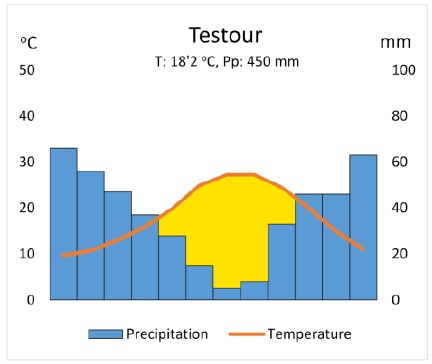
Figure 5. Gaussen ombrothermic diagram for Testour. Source: author, based on Climate-Data.org. [48].